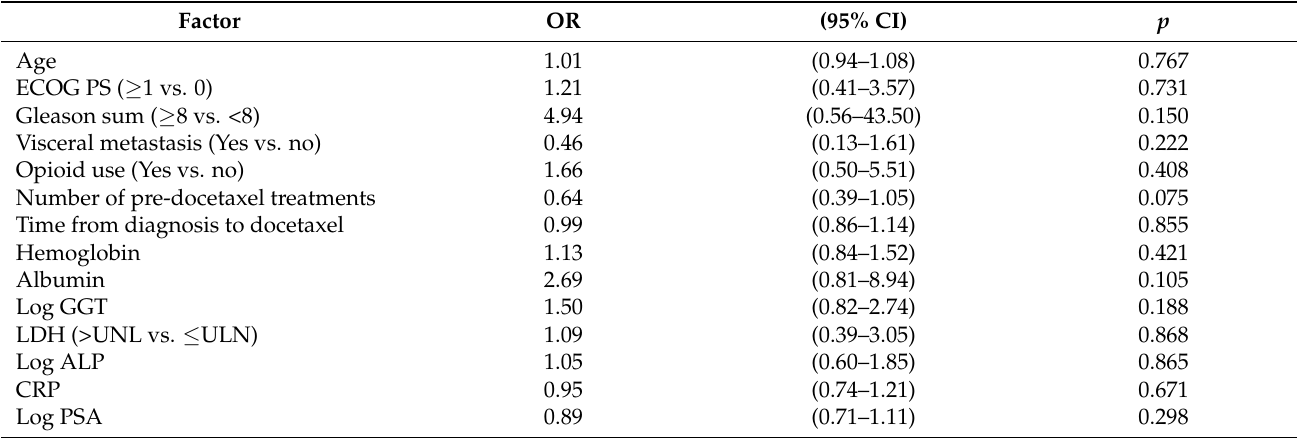
Table 3. Univariable analysis for PSA response at 12 weeks after docetaxel initiation in 78 mCRPC men treated with four or more cycles of docetaxel.